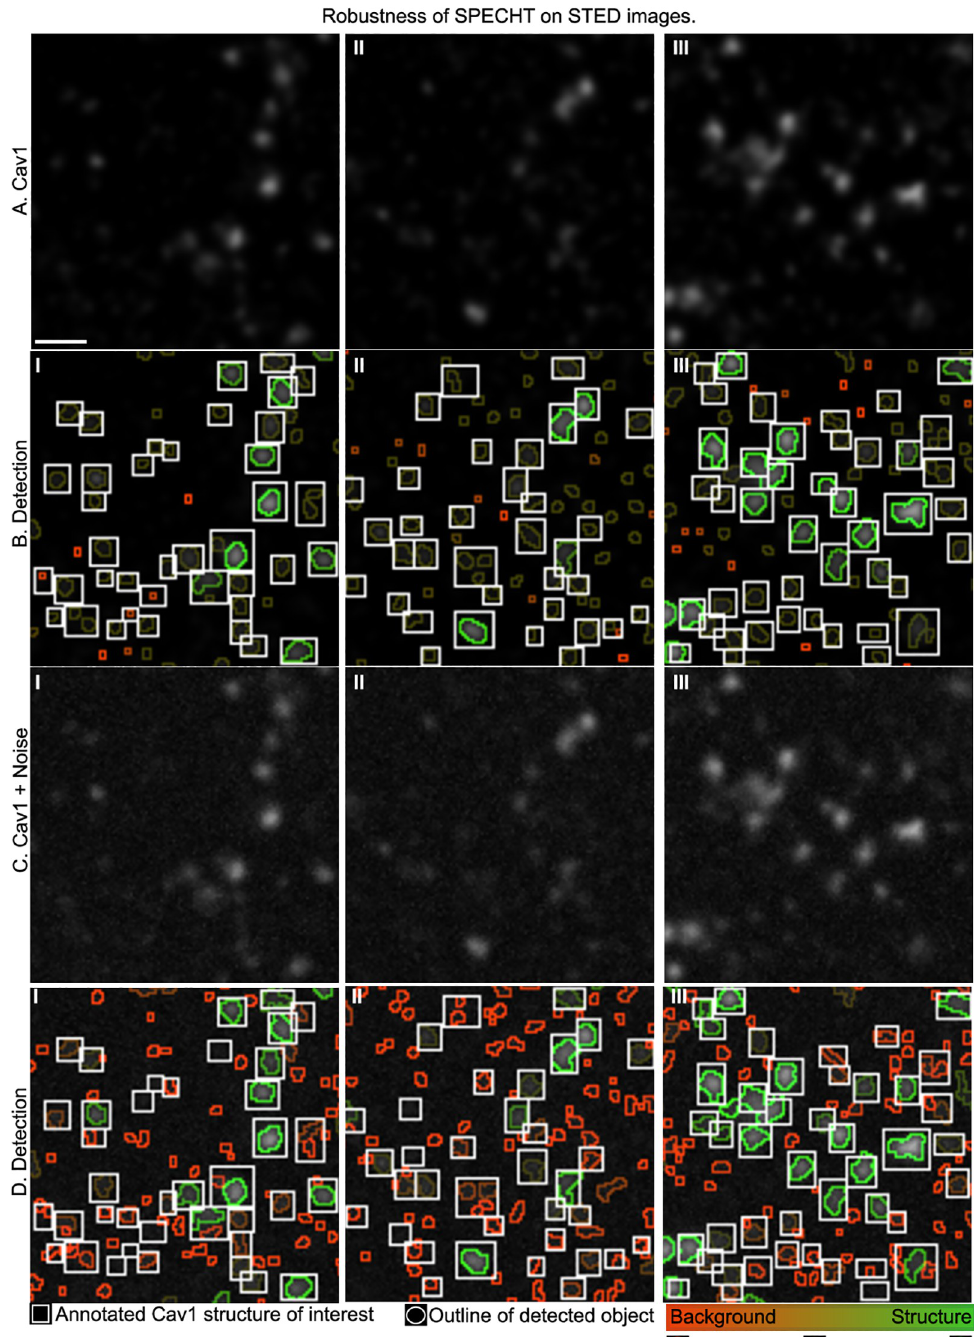
Fig 7. Robustness on partially annotated STED images. We illustrate how the belief stage of SPECHT complements the object detection stage on real world STED microscopy images (A.I-III), subsequently degraded with severe noise (C). We first run SPECHT in high recall mode on selected ROIs of a PC3-CAVIN1 cell, where an expert makes partial annotation (B-white box) of structures of interest. The belief stage then uses a single CAV1 KO cell to learn which identified objects are non-specific labelling (red), versus actual objects of interest (green), on a continuous scale. Next, we repeat the experiment but severely degrade the image with added Poisson and Gaussian noise. The reduced signal to noise ratio induces more artifacts, but the belief stage identifies these as non-specific labelling with high plausibility. Scale bar (A.I) =